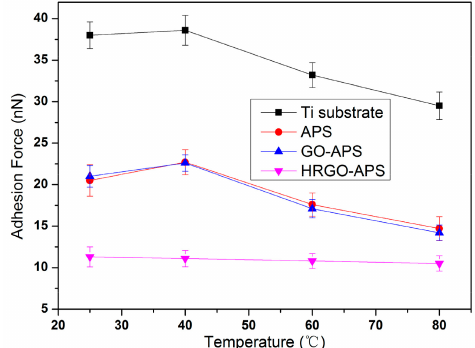
Figure 16. Variation of adhesion forces of hydroxylated Ti substrate and prepared coatings under various Temperature (Applied Load: 70 nN).